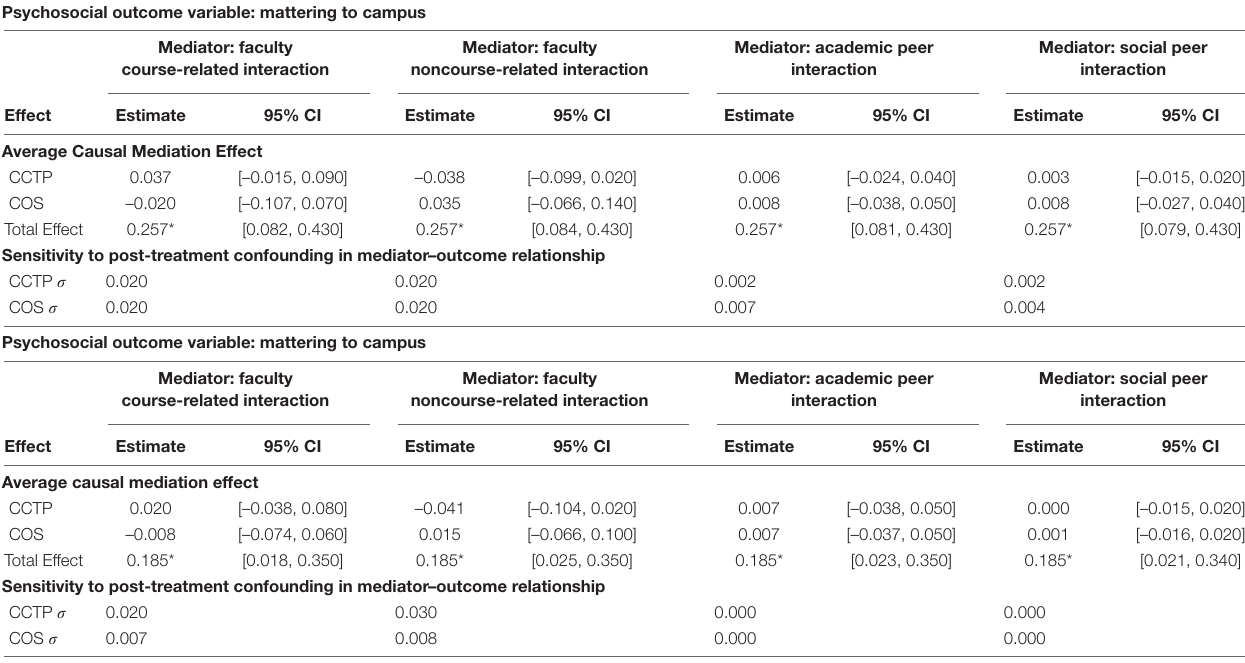
TABLE 5 | Mediation effect estimates assuming dependence among mediators.